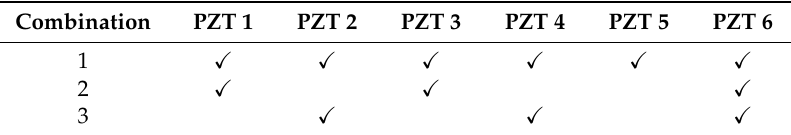
Table 5. Combination of PZT sensors for linear tomography of RMSD index.